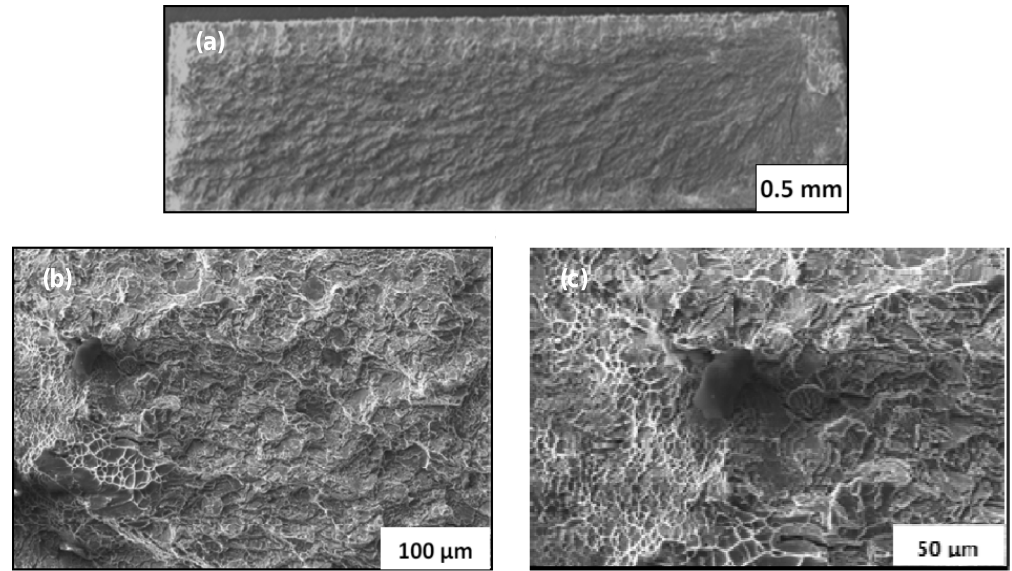
Fig. 6. General view of fractured specimen (a) and details of fractured zone for (b, c) for coarse-grained LFW titanium after tensile testing.